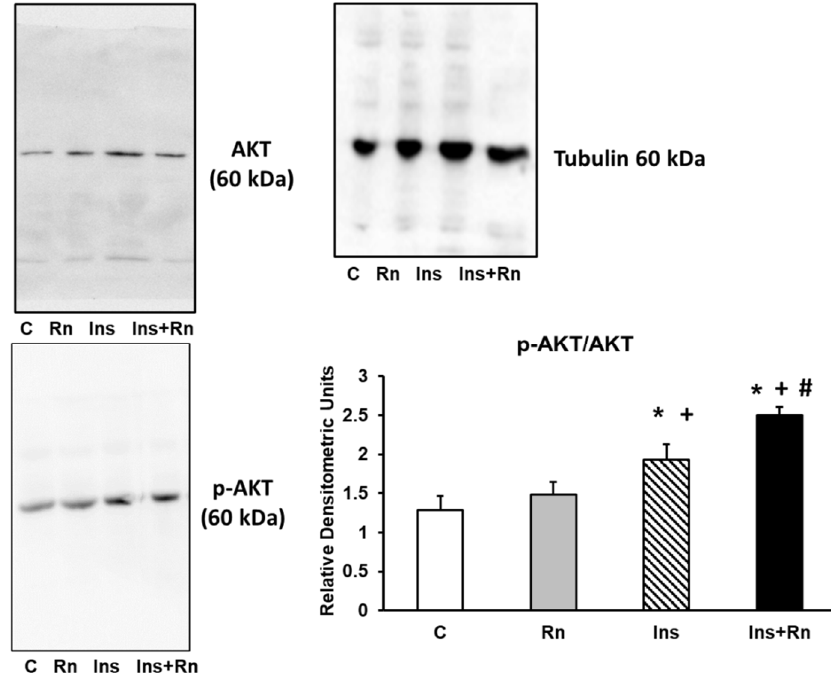
Figure 3. Effect of Ins and Rn on p-AKT and AKT protein expression. Astrocytes were incubated without Ins or Rn (control, C), with Rn (10 − 6 M), with Ins (10 − 8 M), or with Ins + Rn (10 − 8 M + 10 − 6 M) for 24 h and collected to determine p-AKT (1:500), AKT (1:500), and Tubulin (1:3000) protein expressions by Western blot. A representative immunoblot is shown in the panel. Data are mean ± SD of four independent experiments (four different rats). * p < 0.05 vs. control. + p < 0.05 vs. Rn. # p < 0.05 vs.